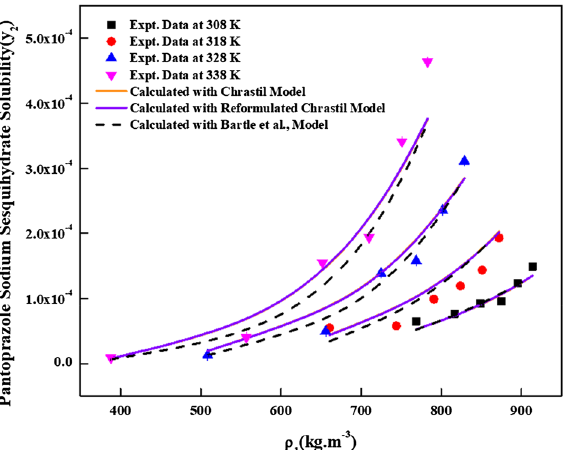
Figure 6. Pantoprazole sodium sesquihydrate solubility vs. ρ 1 . Lines are Chrastil and Reformulated Chrastil model calculations; dashed lines are Bartle et al., model calculations.